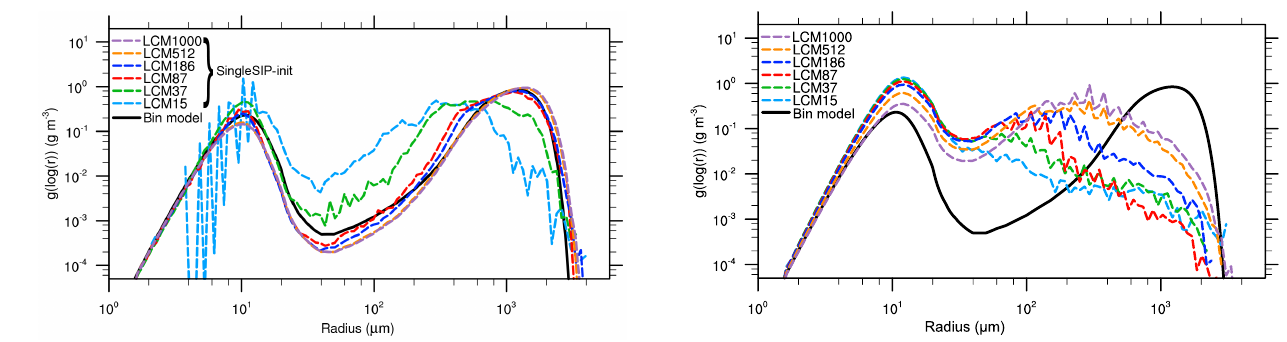
Figure 3. Mass density distribution for the single-box approach af- ter 3600s. The black solid line denotes the solution of Wang et al. (2007). The colored dashed curves show the solution of the LCM with different numbers of superdroplets per grid box.